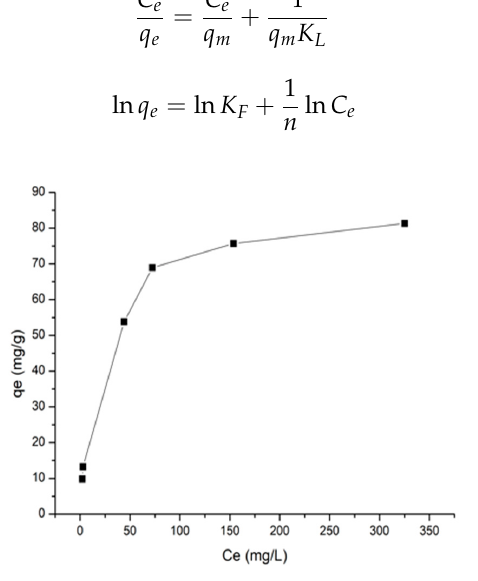
Figure 4. Isothermal adsorption curve of Ca 2+ .